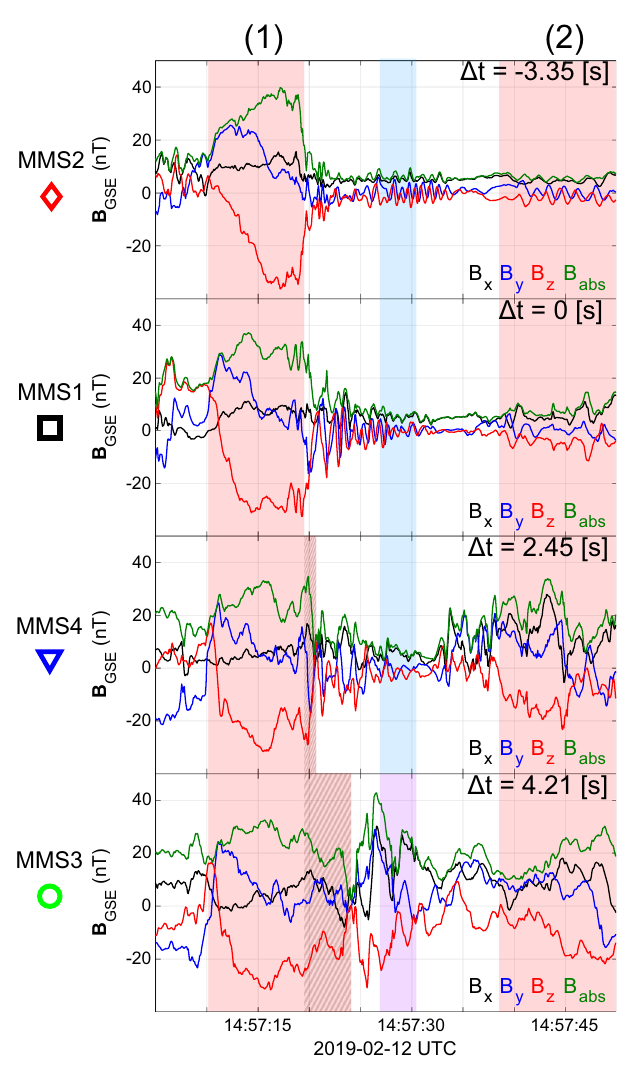
Fig. 7 Time-shifted magnetic fi eld measurements for Magnetosphere Multiscale (MMS) 1 – 4. From top to bottom, magnetic fi eld measurements for MMS2, MMS1, MMS4, and MMS3. All measurements are time-shifted with respect to MMS1 (black square) and each panel indicates the time lag used for each spacecraft. All panels effectively show the evolution of the magnetic fi eld from a point moving with the trailing edge of the (red-shaded region 1). The pile-up region observed by MMS4 and MMS3 is indicated by the patterned red region. This pile-up corresponds to the evolution of the shock ’ s ramp that extends the initial compressive structure. The B measurements corresponding to the magnetosheath jet (MMS3) are shown in purple and the corresponding upstream waves observed by MMS1, 2, and 4 are in